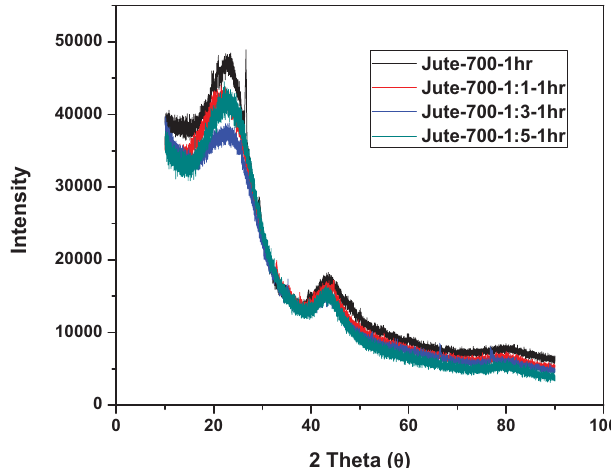
Fig. 2. X-ray diffraction (XRD) pattern of samples.